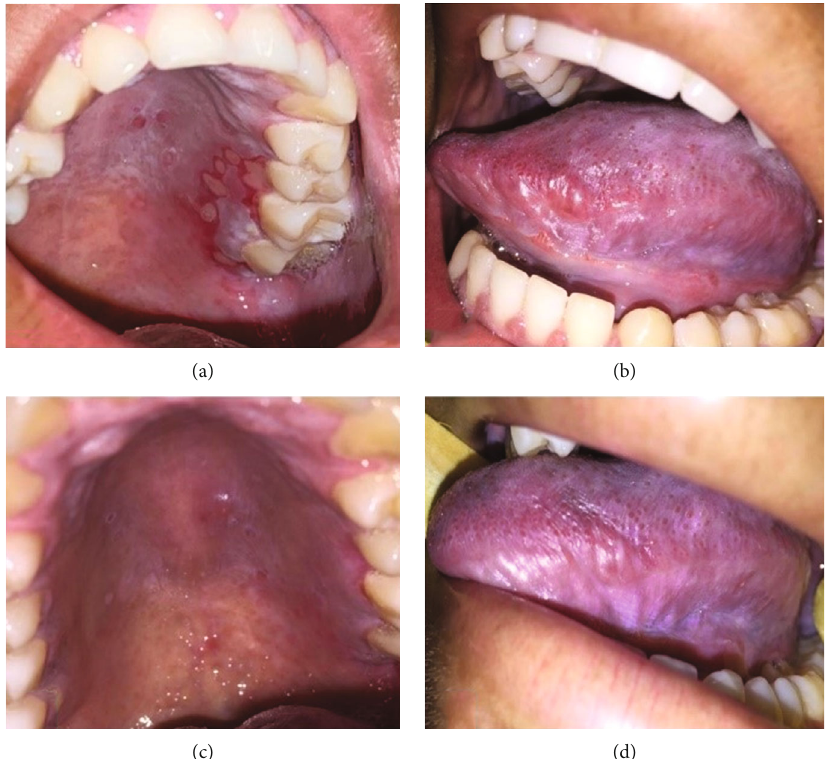
Figure 4: Oral manifestations resulting from radiotherapy and therapeutic evolution of complications. Herpes simplex and Grade 2 mucositis lesions shown in region of the hard palate (a) and in the oropharynx and left lateral border of the tongue (b), respectively. Intraoral clinical appearance after local drug therapy and photobiomodulation (PBM), with regression of lesions in the hard palate (c), oropharynx, and left lateral border of the tongue